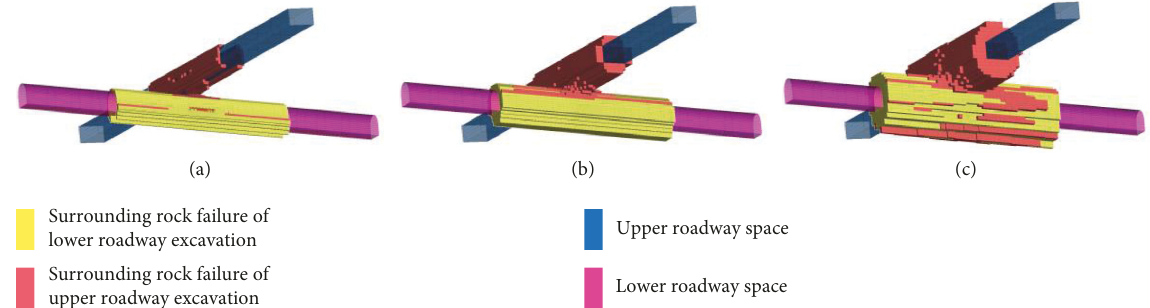
Figure 11: Disturbance influence of buried depth on surrounding rock failure of staggered roadways. (a) 100 m roadway buried depth, (b) 200m roadway buried depth, and (c) 400m roadway buried depth.